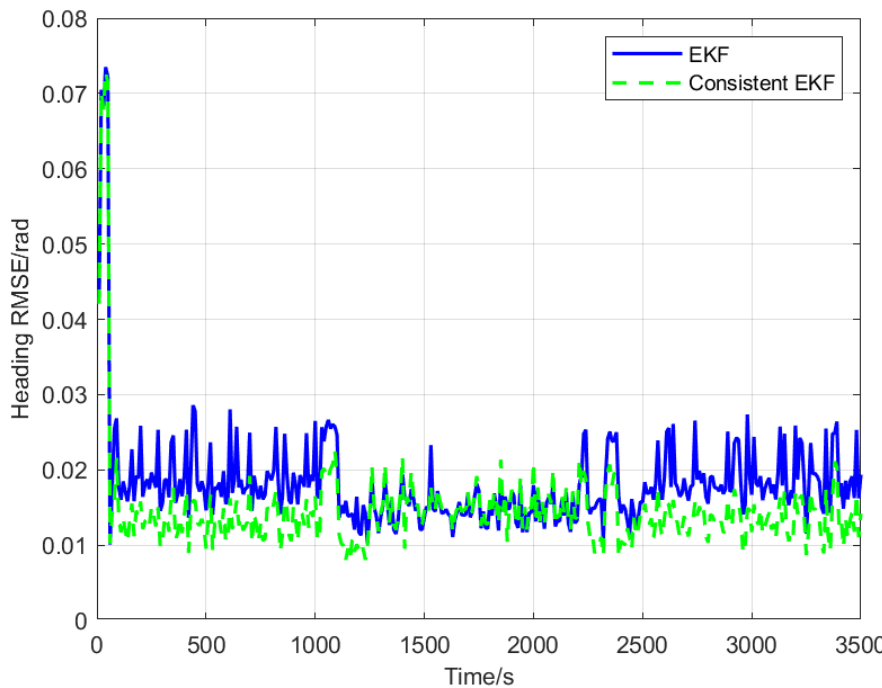
Figure 5. Root mean square errors of